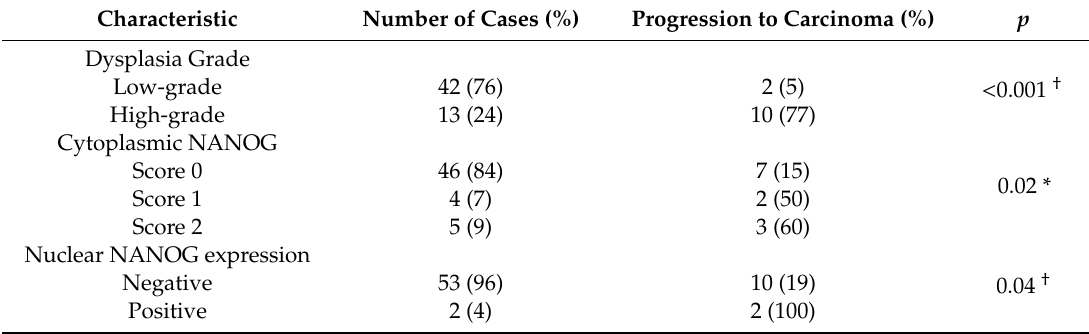
Table 2. Evolution of the premalignant lesions in relation to histopathological diagnosis, and nuclear and cytoplasmic NANOG expression.